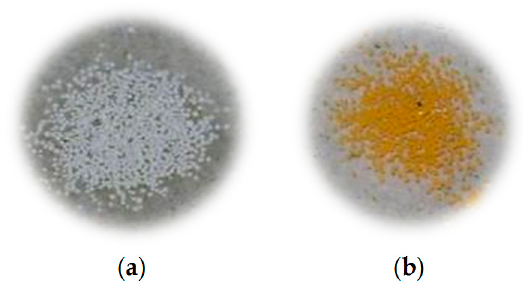
Figure 5. Supported lipase in poly(methylmetacrylate) beads (CALB, Novozym ® 435) before ( a ) and after ( b ) quinizarin diester (QDA) addition, reaction and solvent evaporation.